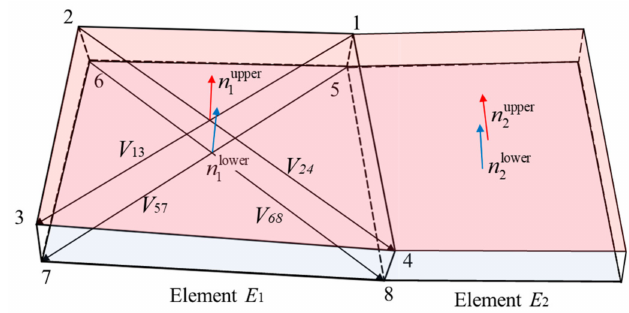
Figure 4. Definition of angle between adjacent elements.